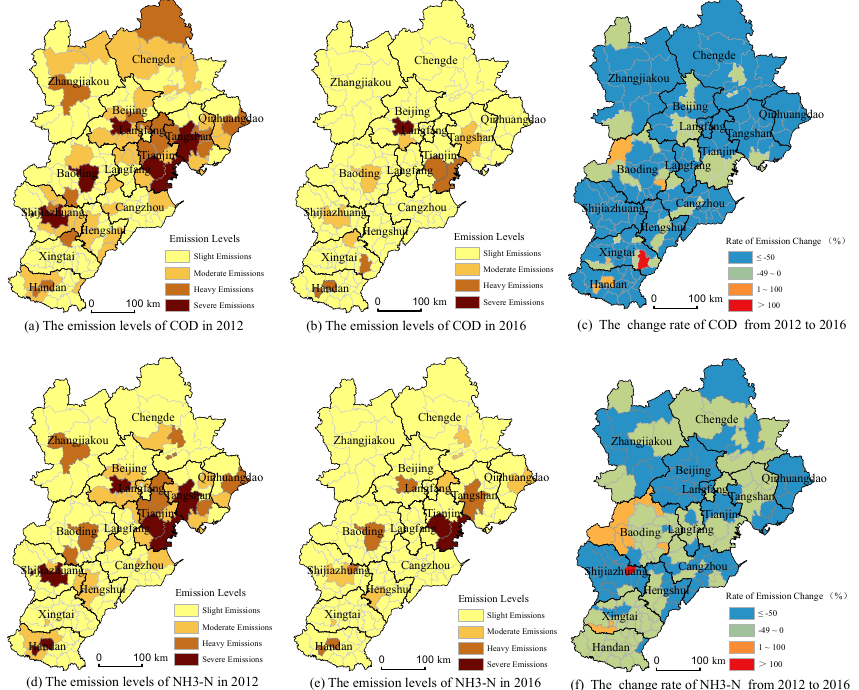
Figure 3. Characteristics of spatiotemporal emissions and water pollutants change in Beijing–Tianjin–Hebei counties from 2012 to 2016.